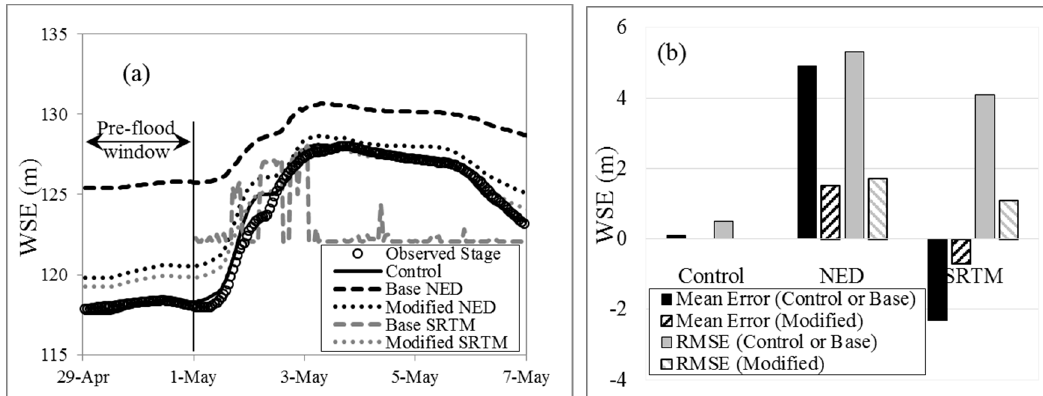
Figure 6. ( a ) Hydrograph for observed and simulated stage at Nashville location; ( b ) performance of the simulated water surface elevation